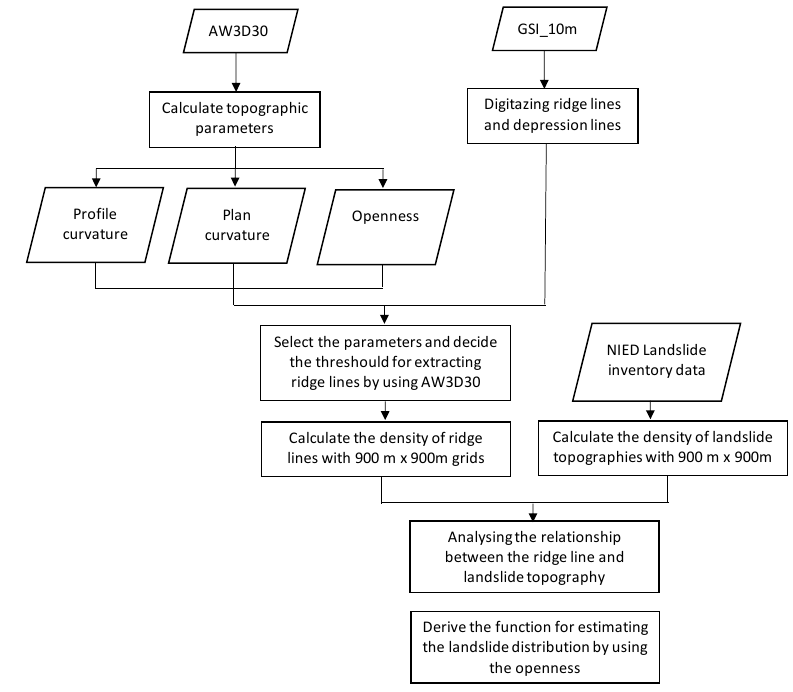
Figure 2. Flowchart of the topographic processing and comparison with landslide inventory data employed in this study